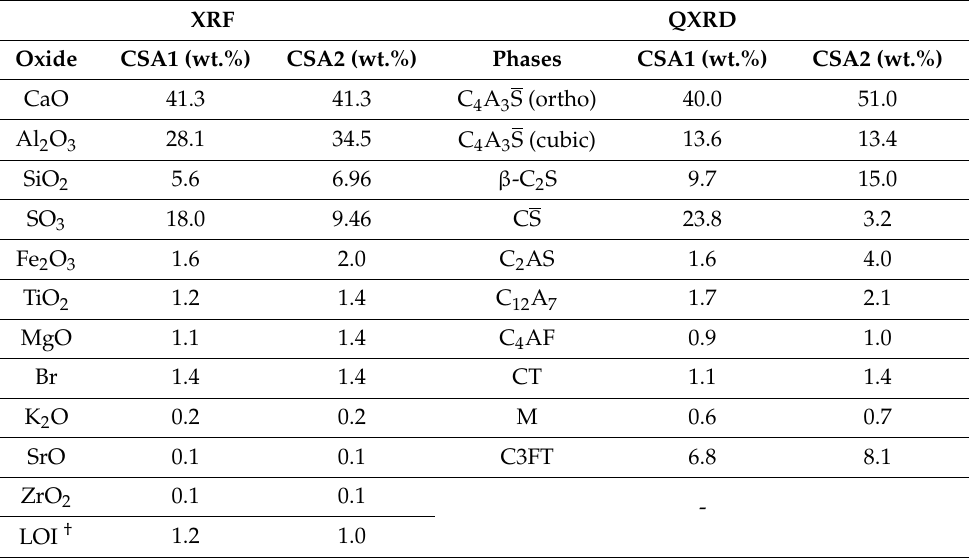
Figure 2. Rietveld refinement results of ( a ) CSA1 and ( b ) CSA2 cements.